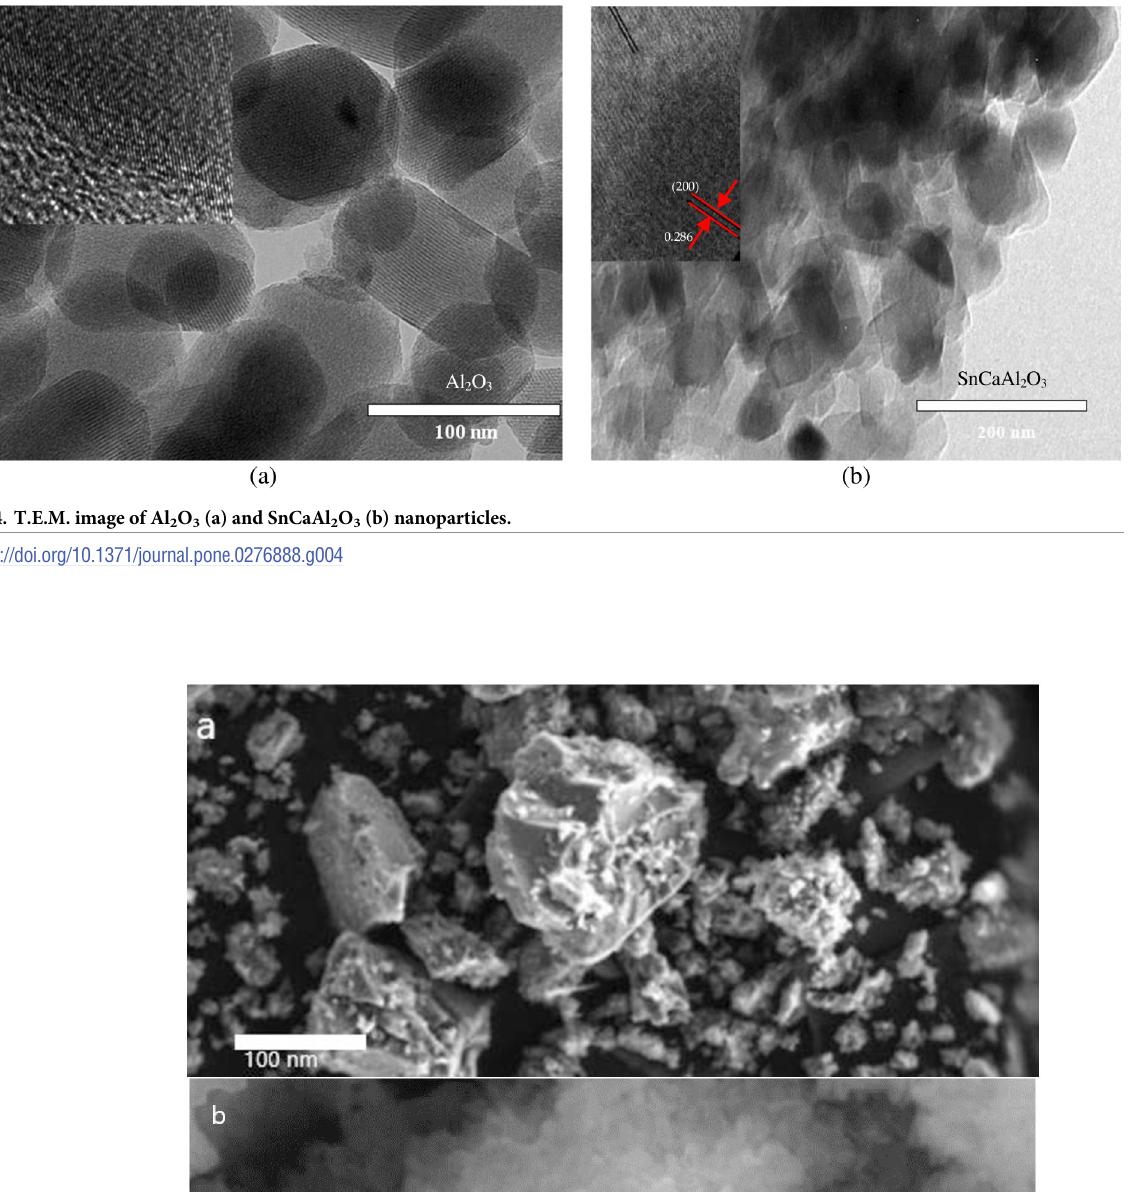
PLOS ONE | https://doi.org/10.1371/journal.pone.0276888 November3,